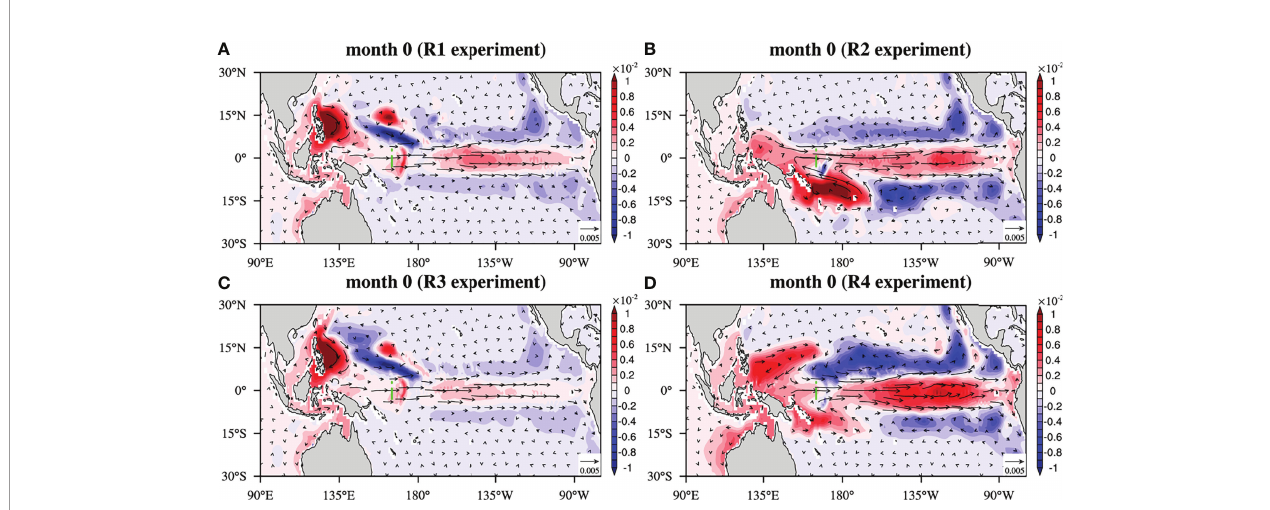
FIGURE 12 | Same as Figure 11 , but the responses of SSHA (color shading; m) and zonal velocity anomalies (vectors: m s – 1 ) at month 0 due to the regional sensitivity-like wind perturbations (A) R1, (B) R2, (C) R3, and (D) R4 (shown in Figure 5B ) exerted at month –